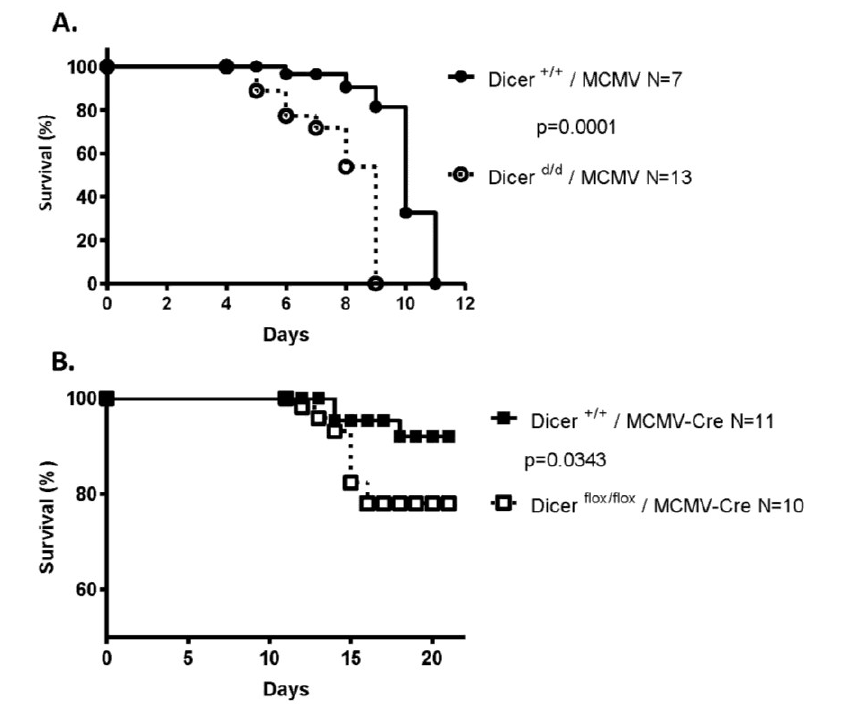
Figure 1. Increased lethality of Dicer-deficient newborns upon MCMV infection. ( A ). Control (Dicer +/+ , N = 7) and mutant (Dicer d/d , N = 13) 4–8 h old neonates were